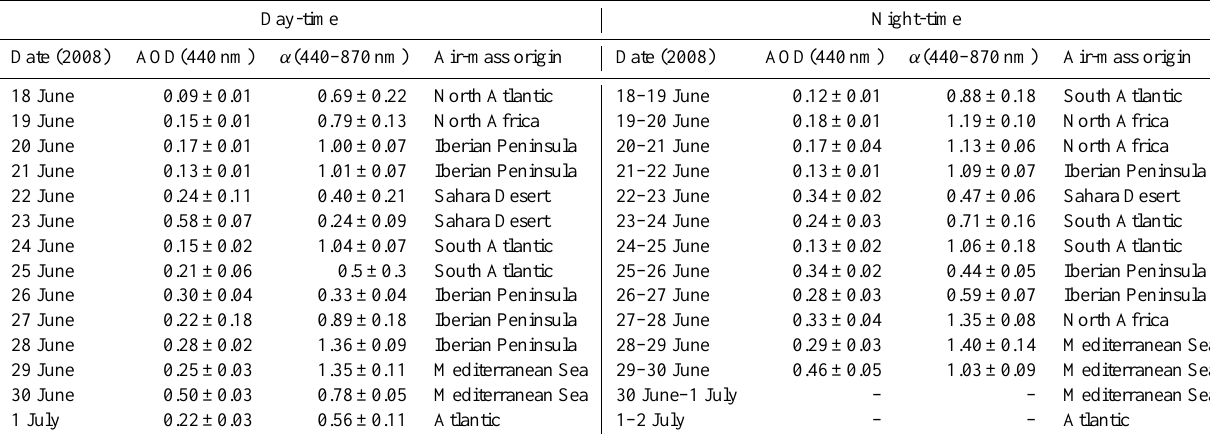
Table 4. Mean values of day- and night-time aerosol optical depth (AOD) and Angstr¨om exponent as well as the associated air-mass types that affected the study area for every day and night between 18 June and 1 July 2008. Air-masses backward-trajectories were computed by HYSPLIT model at 1500ma.g.l.